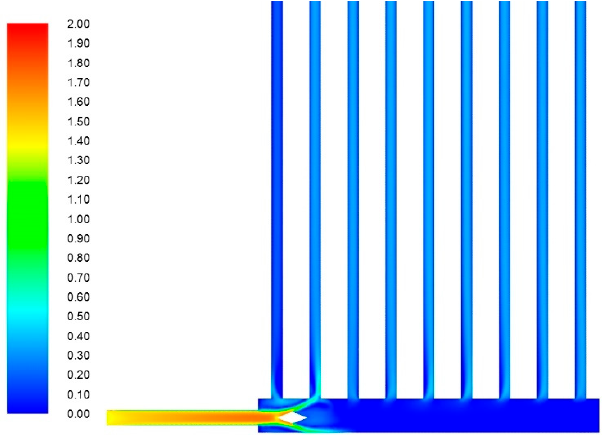
Figure 15. Sample of velocity contours in the U-type adopting a novel design.